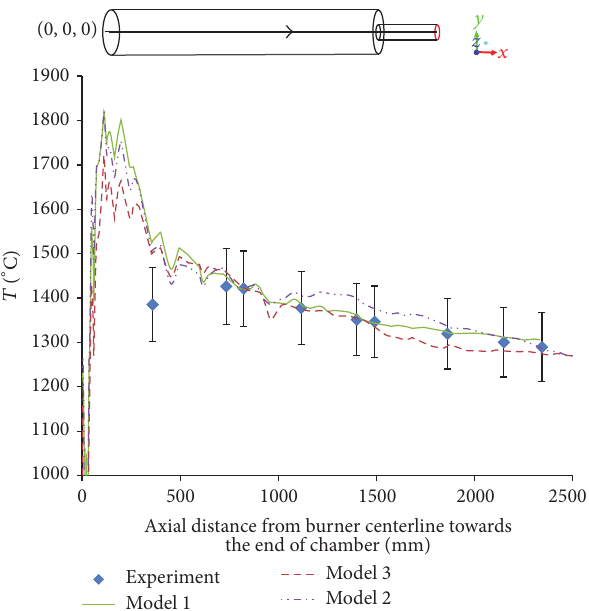
Figure 7: Temperature magnitudes on the axial line of the chamber from burner centerline towards the end of the chamber.